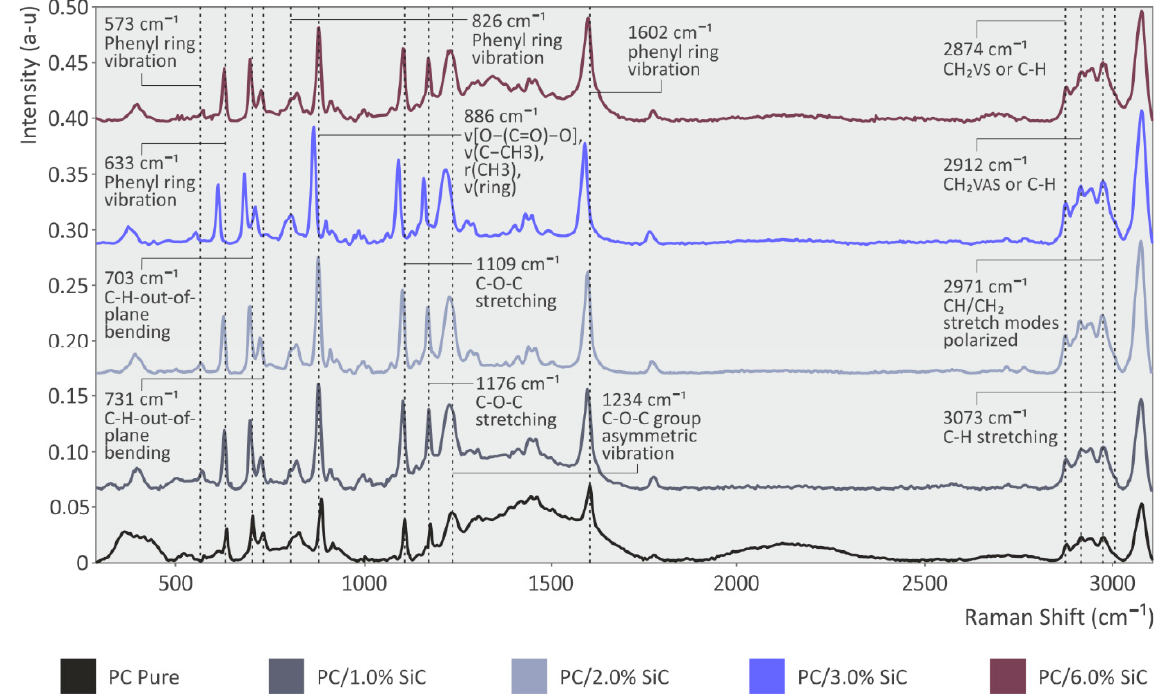
Figure 4. Pure PC and PC/SiC nanocomposites Raman spectra results. Table 1. The Raman spectra differences in behavior (clear PC and PC/SiC